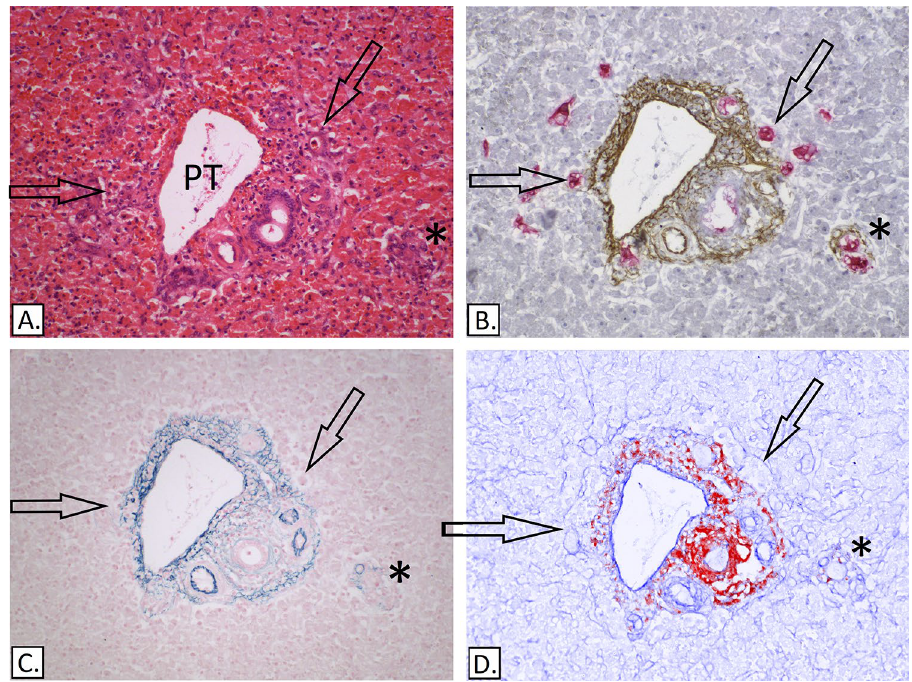
Figure 3. Liver from a patient with a paracetamol overdose. A portal tract (PT) occupies the central part of the field. ( A ) H&E. ( B ) IHC-Elastin DAB (ab9519) and cytokeratin 19 (CK19), (NCL-CK19) in red. ( C ) Victoria blue. ( D ) IHC-collagen I (ab6308) in red & collagen III (ab7778) in blue, spectrally unmixed channels from Nuance camera + software. Arrows identify peri-portal ductular epithelium confirmed by the expression of CK19. Collagen I fibre bundles are restricted to portal tracts. Asterisks show a tangentially cut portal